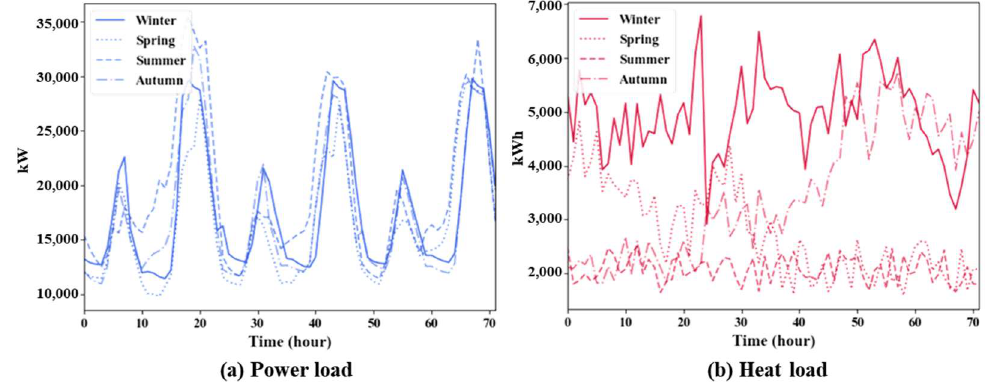
Figure 4. Seasonal load profile of power and heat. Table 2. Facilities economical parameters.